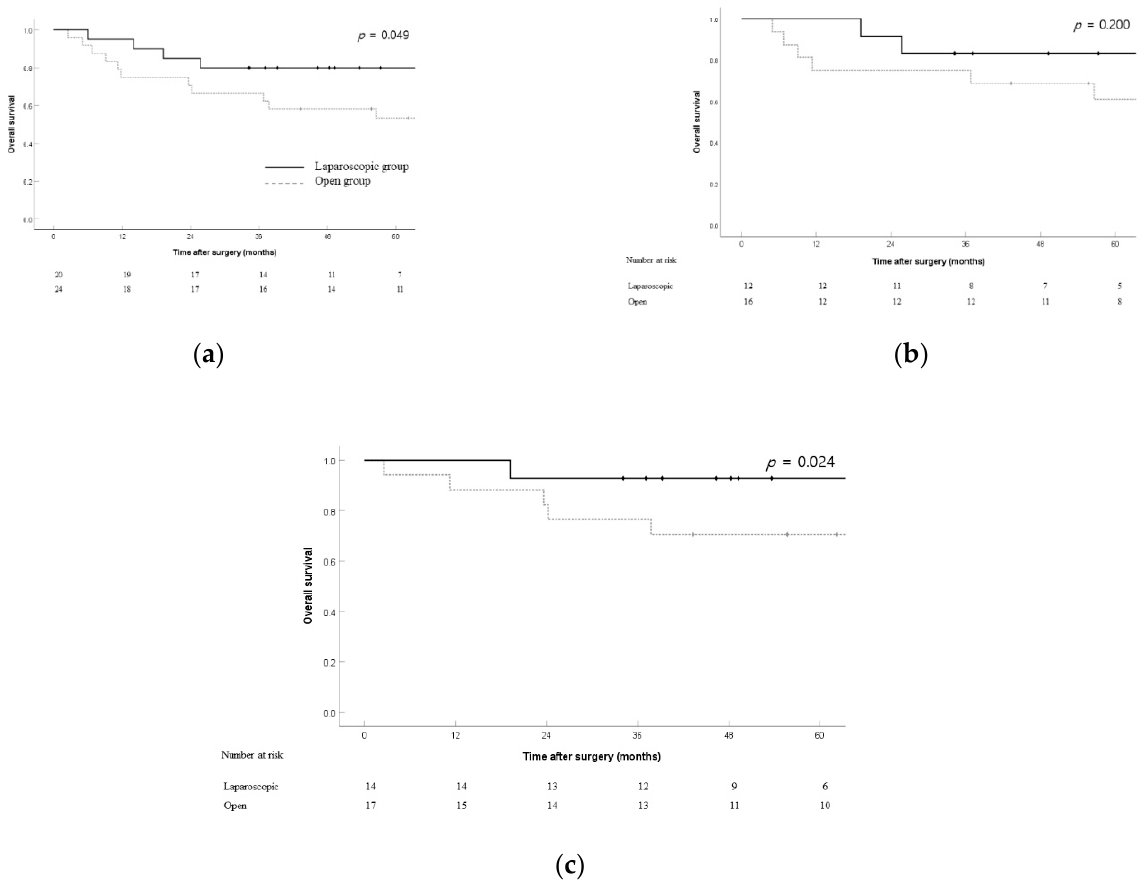
Figure 1. Overall survival between the laparoscopic and open groups in the overall cohort ( n = 44) ( a ), T2 patients ( n = 28) ( b ), and N0 patients ( n = 31) ( c ). To exclude non-cancer-related deaths, tumor-specific deaths of both groups were investigated and additional survival analyses were performed. When comparing tumor- related deaths, survival rates were not significantly different between the two groups (5 year tumor-specific OS rate: 84.7% vs. 62.5%; p = 0.125) (Figure 2a). Among patients with stage T2 tumors, the 3 year OS rates were 90.9% and 75.0% in the laparoscopic and open groups, respectively; the difference was not statistically significant ( p = 0.256) (Figure 2b). Among patients with stage N0 tumors, the 3 year tumor-specific OS rates were 100% and 76.5% in the laparoscopic and open groups, respectively; the difference was statistically significant ( p = 0.028) (Figure